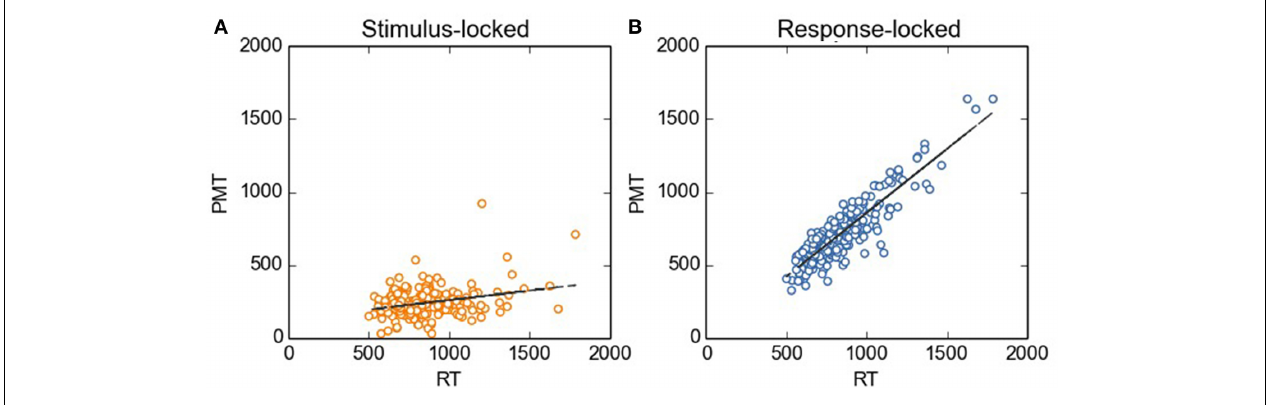
FIGURE 2 | Stimulus-locked (A) and response-locked (B) PMT as a function of RT. Before carrying out the regression analysis described in the main text, we removed the between-subjects